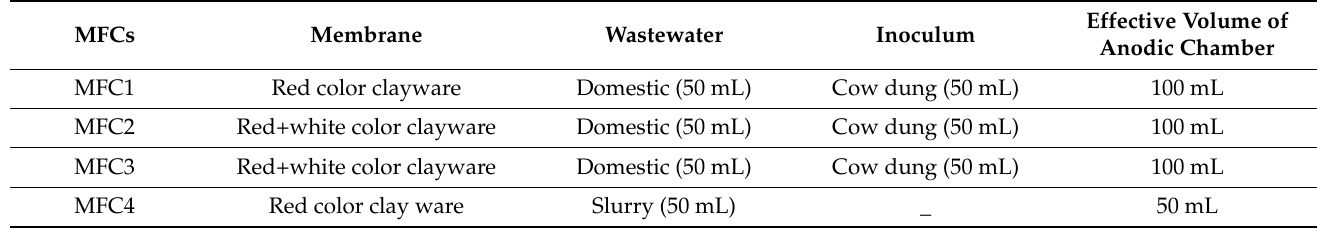
Figure 4. Configuration of MFC modules and separator electrode assembly. Table 1. Details of different MFC modules